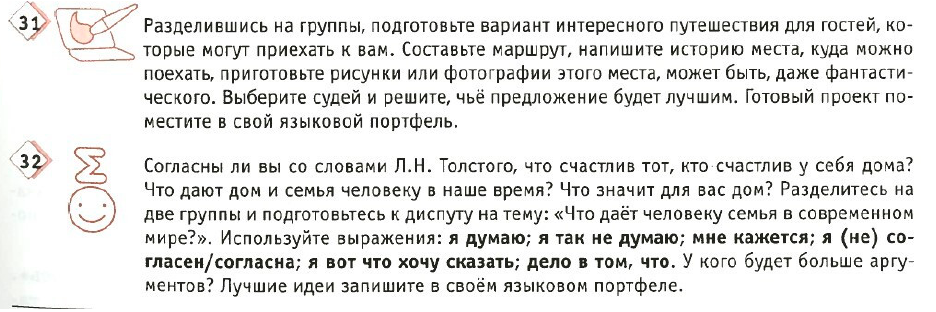
Figure 4. Example 2 of a task in Russkiy klass .